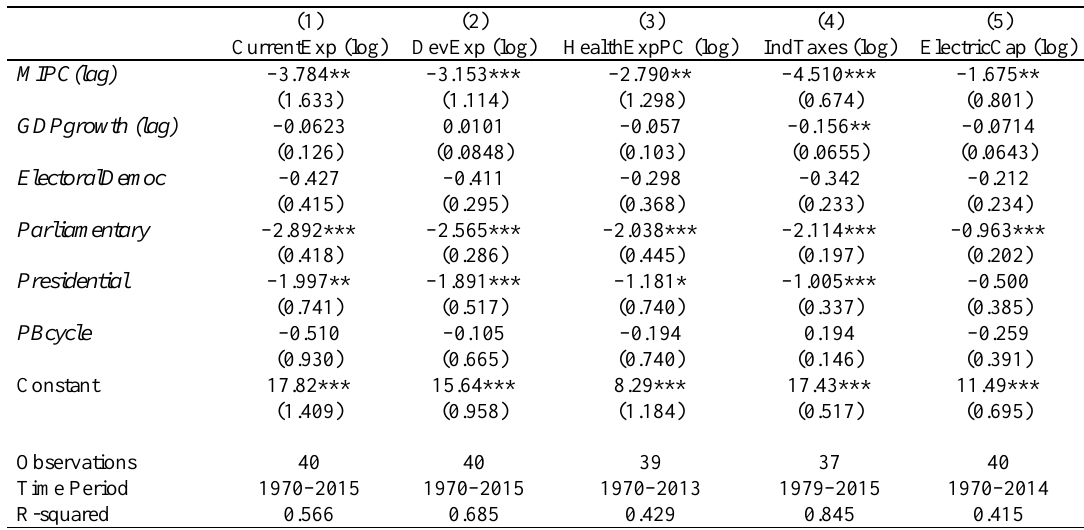
Table 4: Political competition and policy indicators (at national